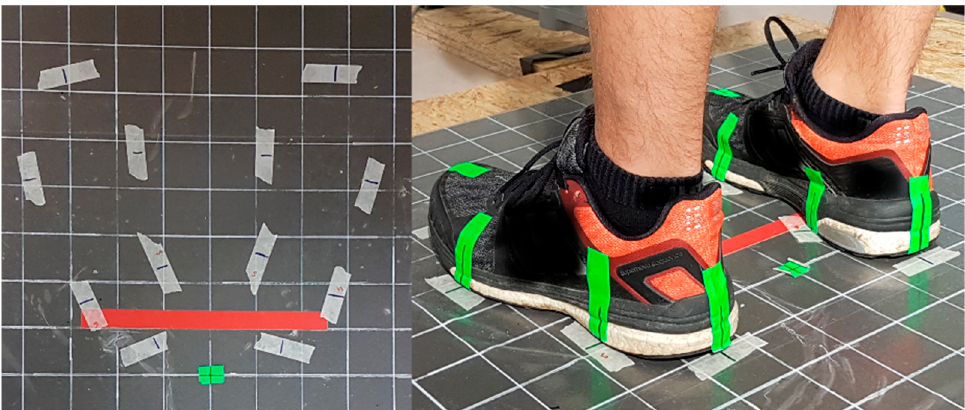
Figure 2. Force plate prepared with a coordinate system and with the individually pre-adjusted and pre-marked foot positions for the different tasks (static and dynamic). Marked landmarks were the heel in line with the Achilles tendon, medial and lateral malleolus, medial and lateral sesamoid, and the forefoot. Tape was placed on the subjects’ shoes and on the force plate, and a connecting line was drawn between each pair of foot-to-floor tape markings considering the above outlined landmark positions. The malleolus markers were later used to determine the x and y coordinates of the ankle joint centers for both feet; by calculating the midpoints of the lateral and the medial malleoli.